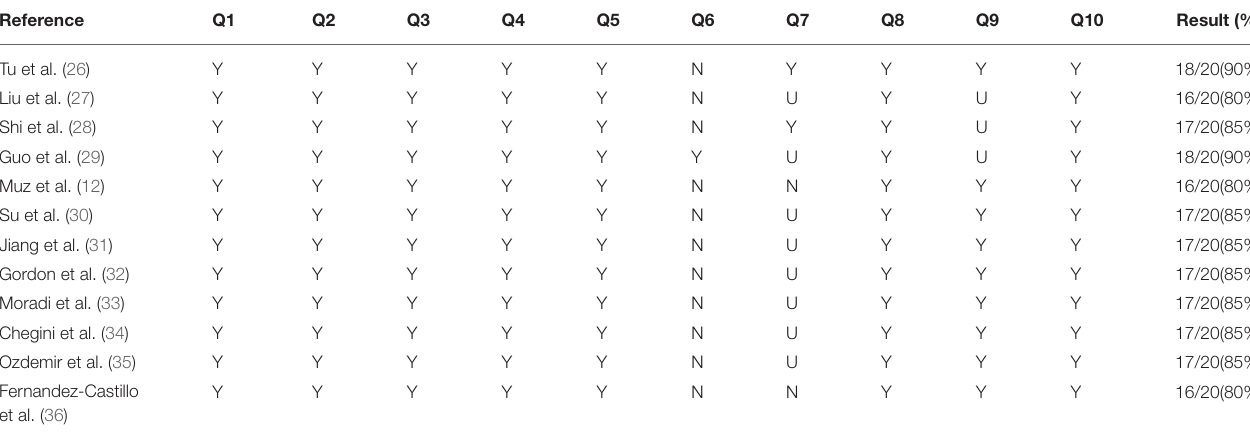
TABLE 1 | Quality assessment of included studies in accordance with the criteria of the Joanna Briggs Critical Appraisal tool for qualitative research.